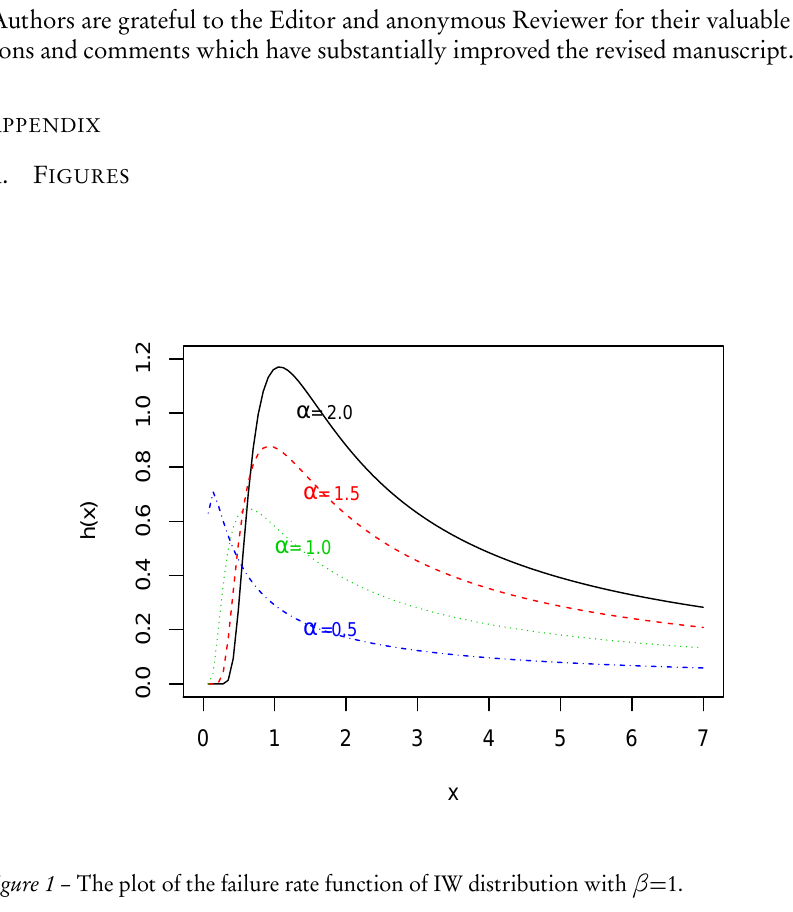
Figure 1 – The plot of the failure rate function of IW distribution with β =